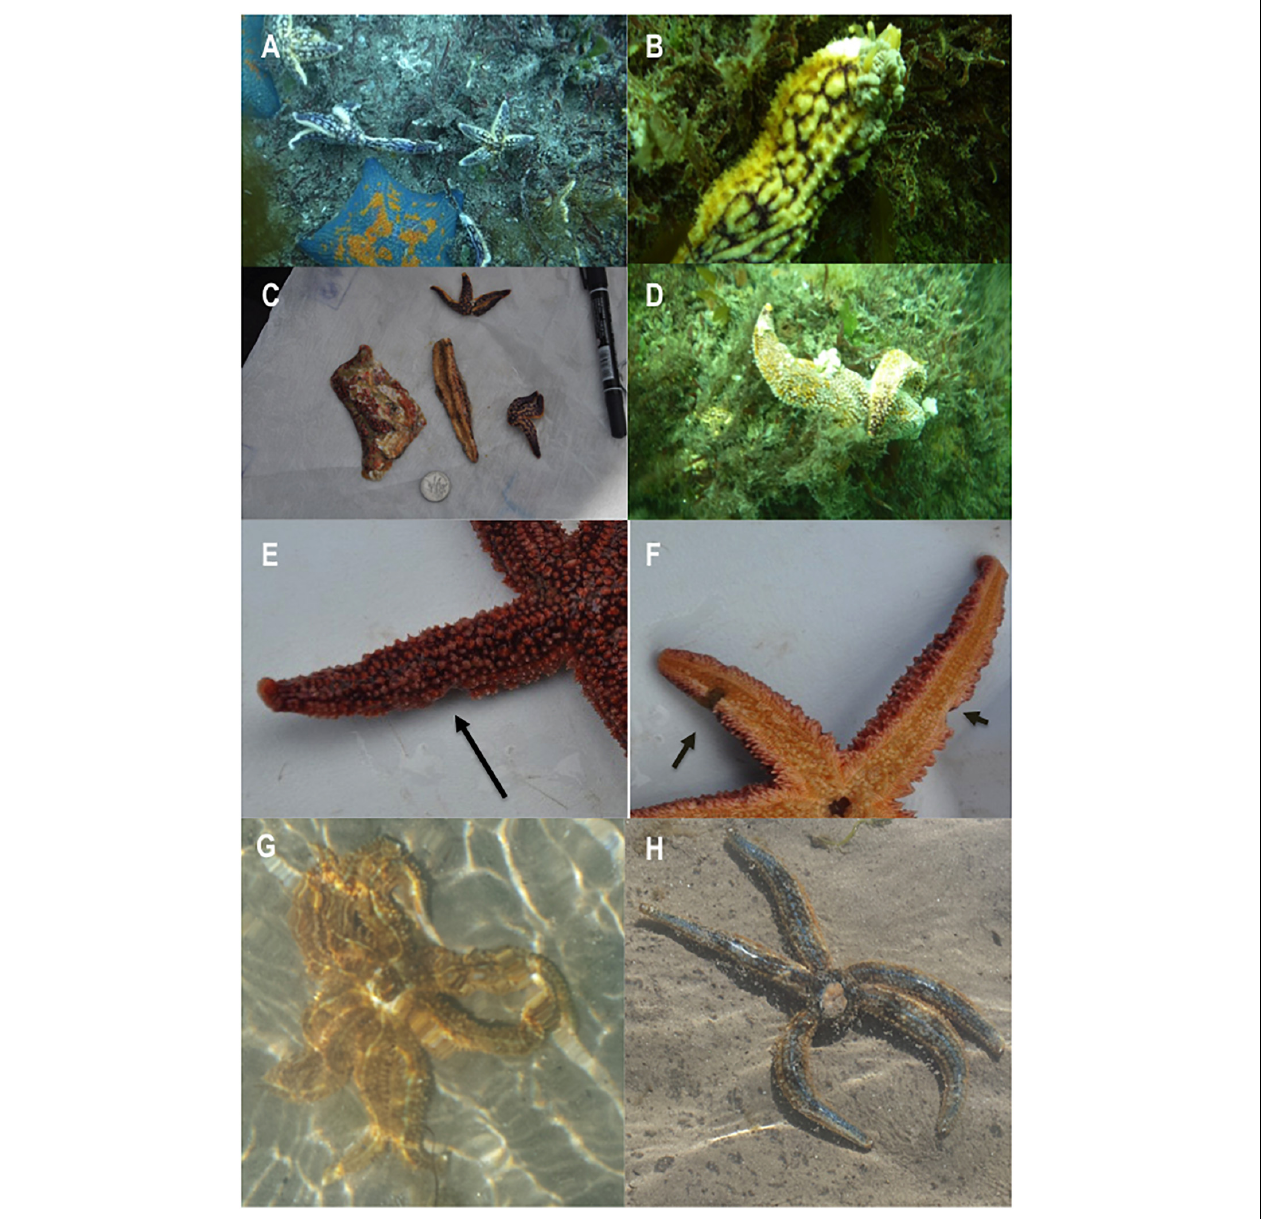
FIGURE 2 | Wasting signs in four species of asteroid. (A) Asterias amurensis with sympatric Patria pectinifera from the Yellow Sea, April–June 2015; (B) Autotomized limb of A. amurensis ; (C) A. amurensis recovered in the lab; (D) Distolasterias nipon; (E,F) Aphelasterias japonica showing arm lesions (denoted by black arrows); (G,H) Coscinasterias muricata inhabiting Port Phillip Bay, Australia, September–October